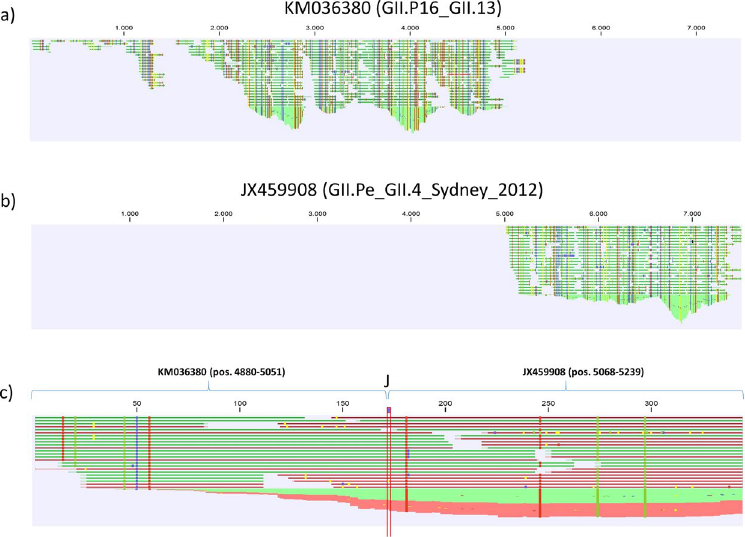
Figure 5. Read mappings for the recombinant NoV strain. ( a ) Mapping of reads to the reference sequence KM036380 (GII.P16_GII.13), ( b ) Mapping of reads to the reference sequence JX459908 (GII.Pe_GII.4_ Sydney_2012), ( c ) Analysis of reads spanning the recombination junction region. This was performed by constructing an in silico reference sequence composed of pos. 4880 to 5051 of KM036380 joined with pos. 5068 to 5239 of JX459908 (the junction is marked with a “J”); reads were subsequently mapped to this reference sequence to identify junction-spanning